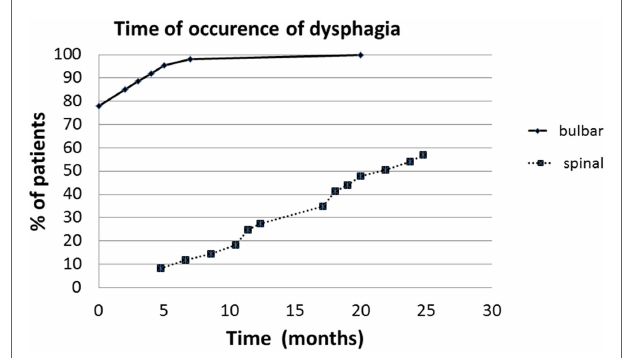
FigUre 1 | The delay between the onset of symptoms and beginning of dysphagia in spinal and bulbar als (months) .